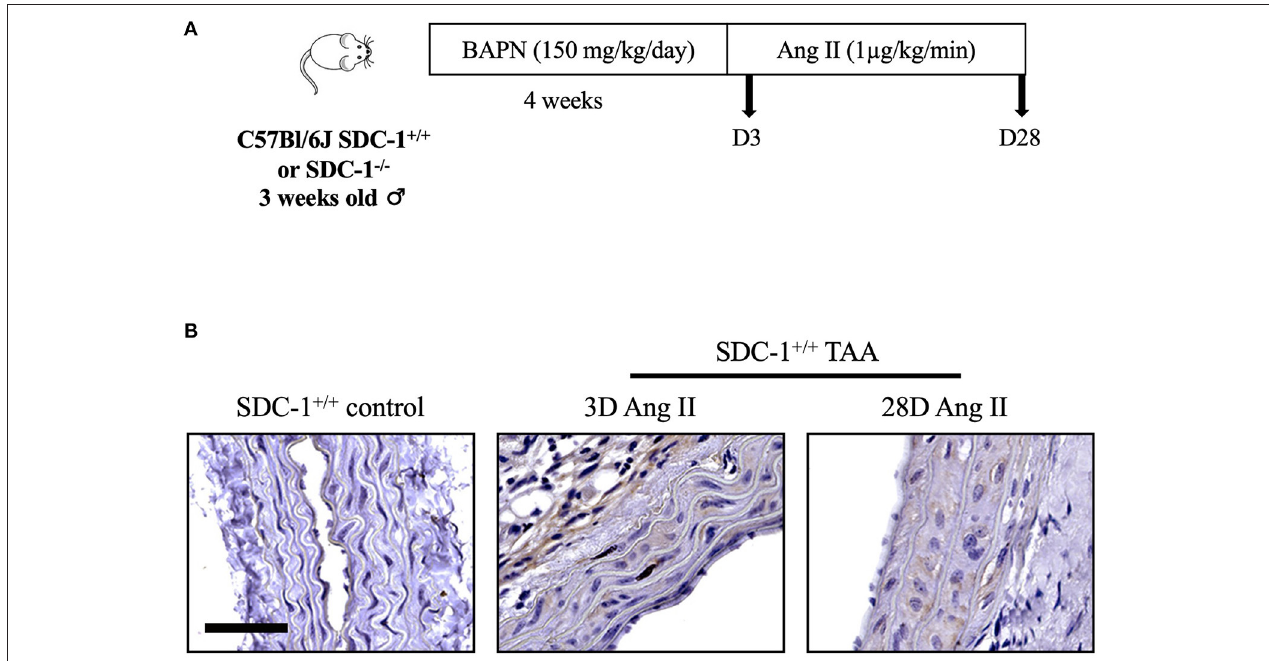
FIGURE 2 | SDC-1 is overexpressed in TAA compared to control aortas in the BAPN/AngII aneurysm mouse model. (A) Experimental model used. SDC-1 + / + or SDC-1 − / − male C57Bl/6J mice at 3 weeks old received intraperitoneal injection of β -amino propionitrile (BAPN) for 4 weeks followed by subcutaneous infusion of angiotensin II (Ang II) by pump implantation for 3 (D3) or 28 (D28) days, then sacrificed. (B) Representative images of SDC-1 immunostaining in control ( n = 3) and TAA specimens after 3 ( n = 2) or 28 days ( n = 3) of Ang II infusion. Scale bar corresponds to 50 µ m.